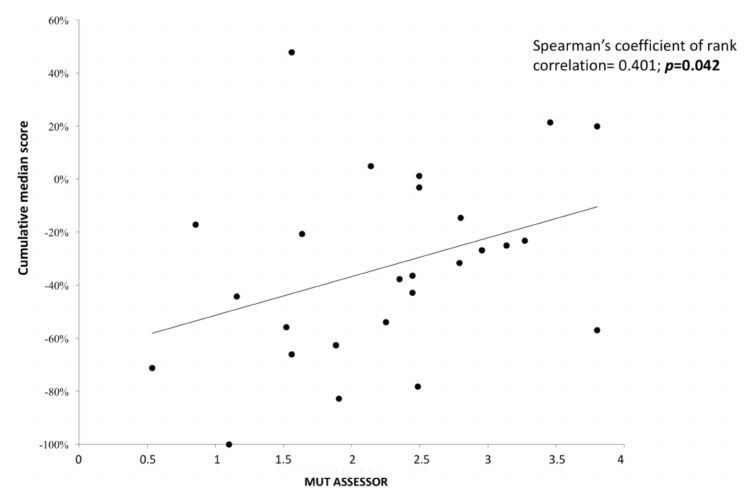
Figure 5. Correlation analysis of the cumulative average score from the five Alamut Visual ® splicing predictors with the MutationAssessor scores calculated for 26 HGMD missense mutations ≤ 3 nucleotides from the nearest splicing site. The data points for this graph are in Table